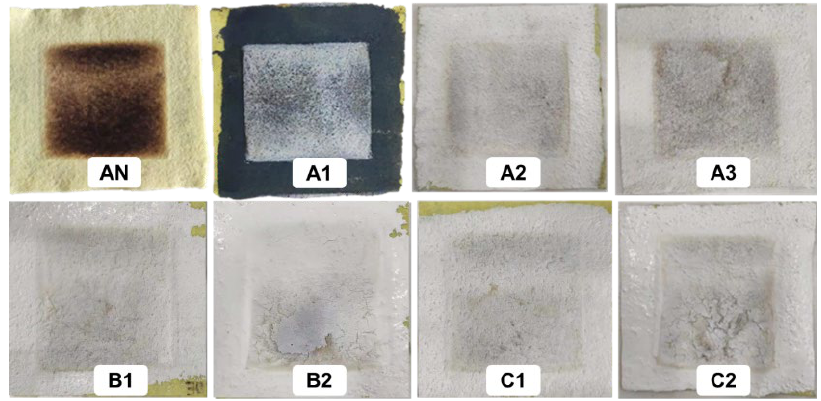
Figure 7. Images of the burned specimens after the TPP